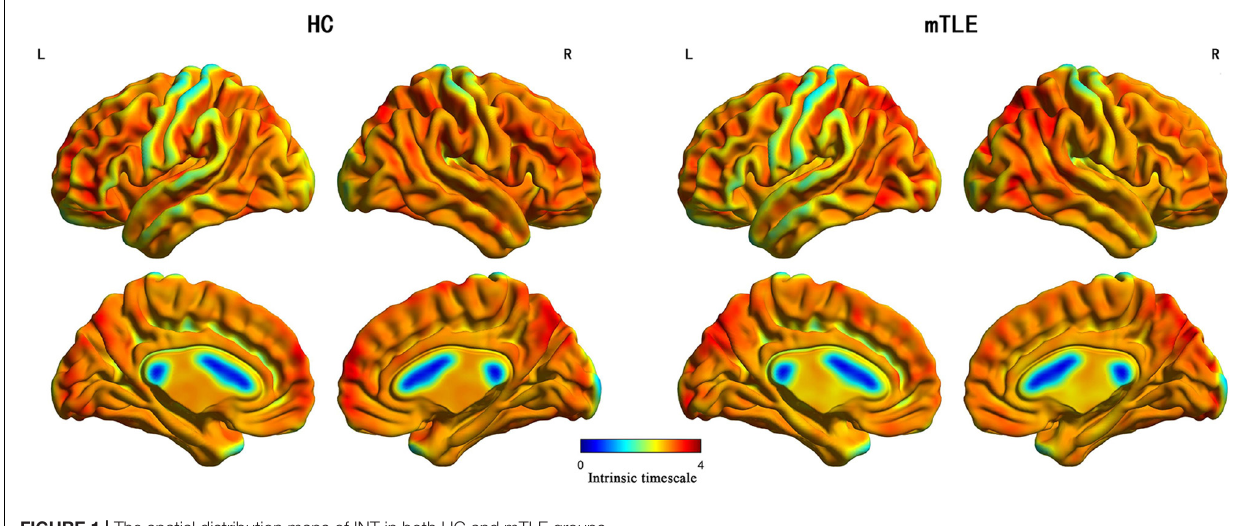
FIGURE 1 | The spatial distribution maps of INT in both HC and mTLE groups.